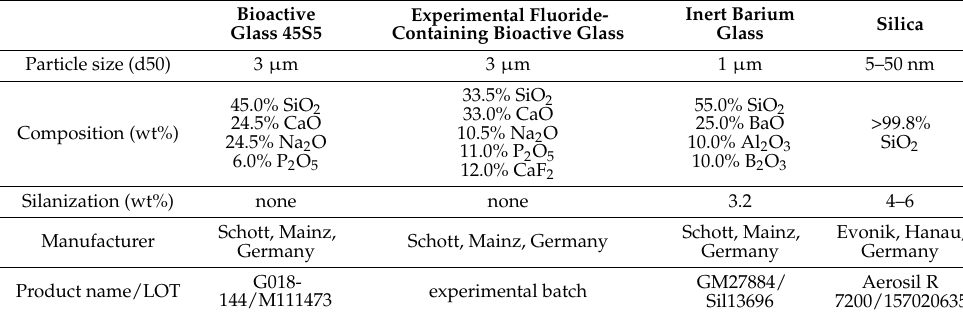
Table 1. Bioactive glass and reinforcing fillers used in experimental composites.